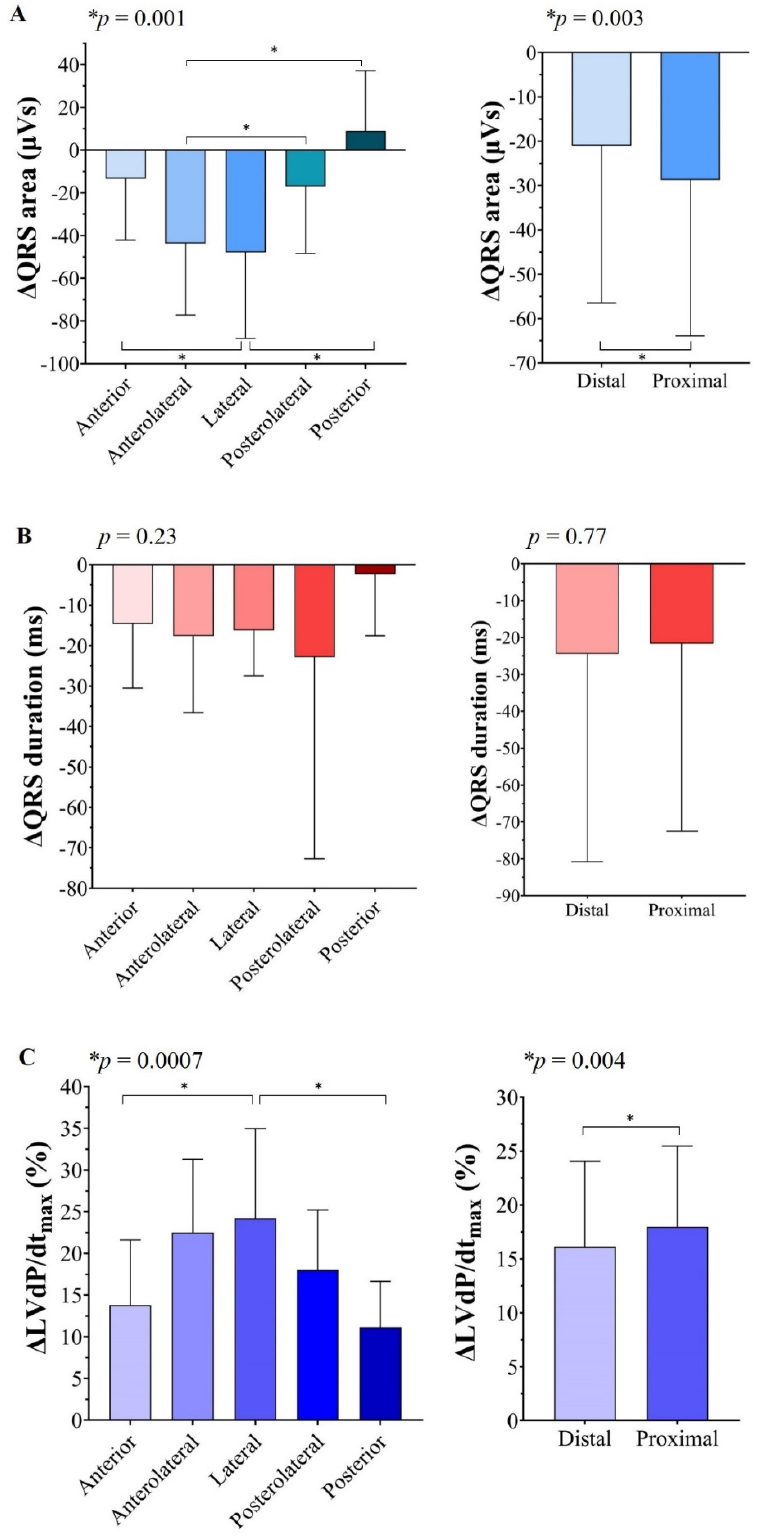
Figure 3. ∆ QRS area ( A ), ∆ QRS duration ( B ), and ∆ LVdP/dt max ( C ) with different pacing locations. Left: p -values calculated with mixed-effects analysis and Sidak’s multiple comparison test. Right: p -values calculated with paired sample T -test. * p < 0.05.